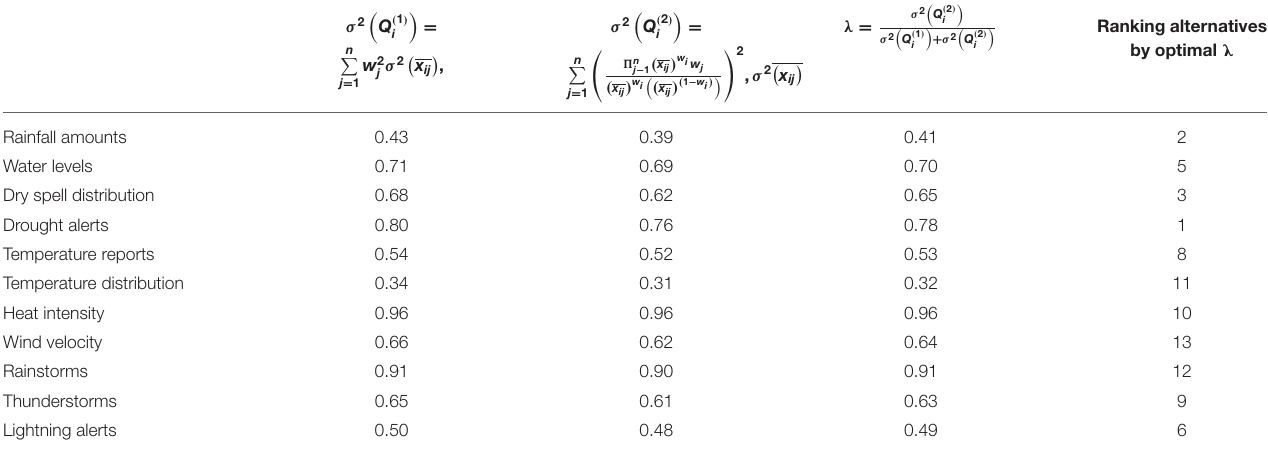
TABLE 13 | Optimality criteria by applying weight aggregation of WASPAS